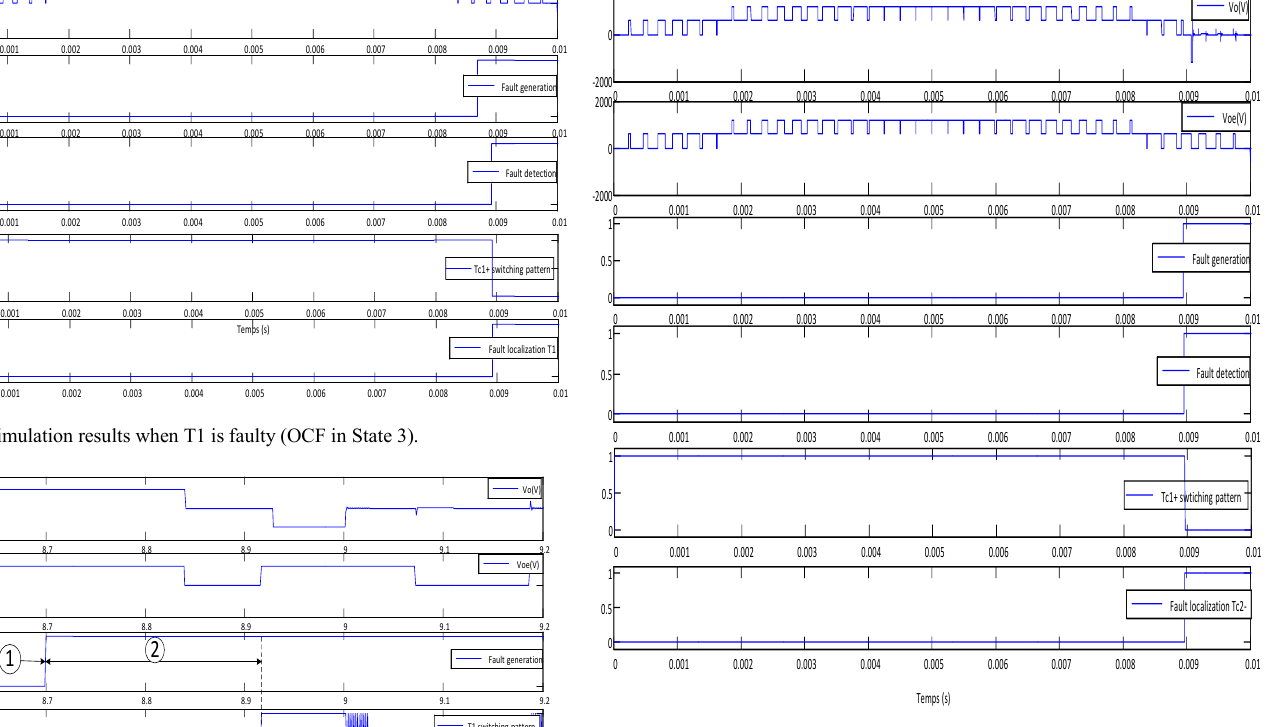
Fig.13 : Simulation results when Tc2- is faulty (OCF in state